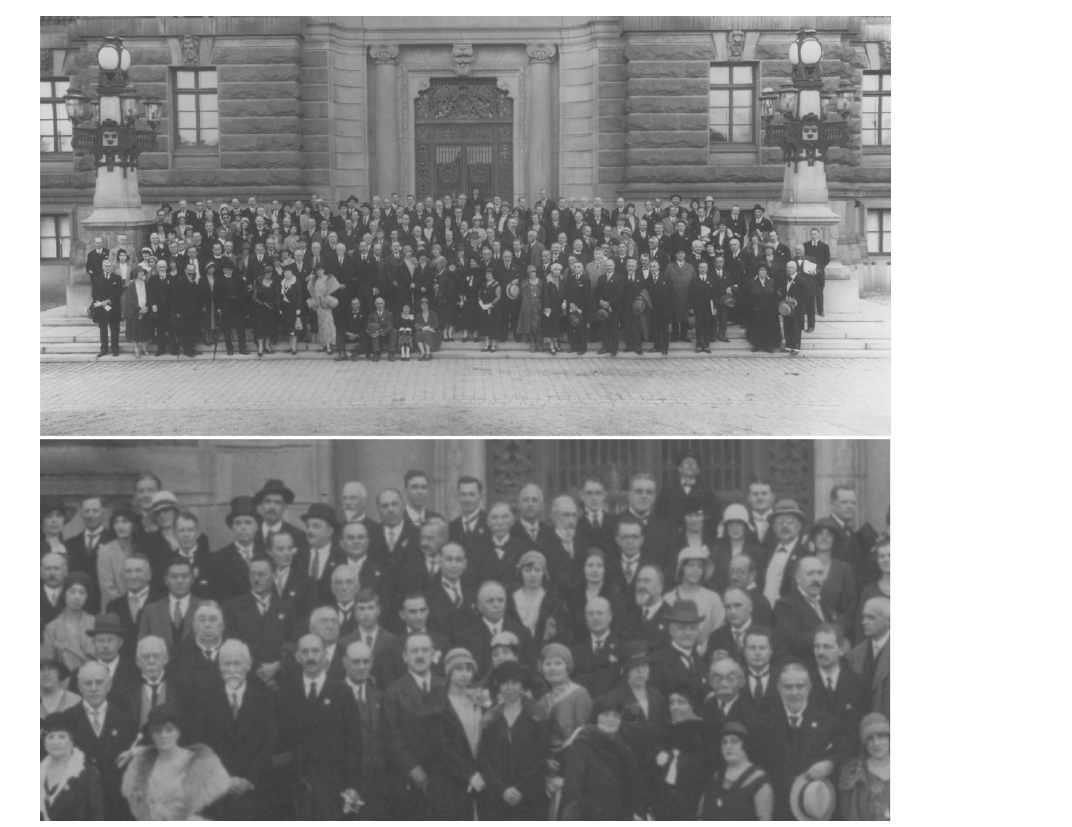
Figure 5. Participants of the Fourth General Assembly (upper panel); details of the central part of the photo (lower panel) (source: IUGG